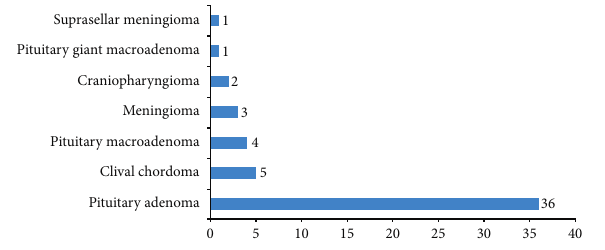
Figure 1: Histopathological final